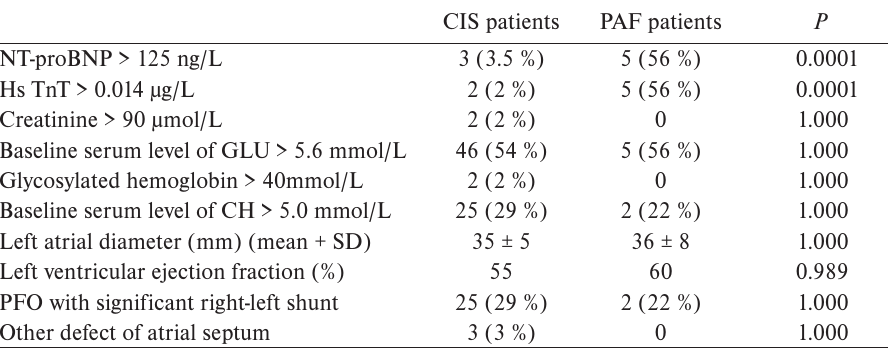
Table 2. Laboratory parameters and TEE findings of CIS and PAF patients. CIS